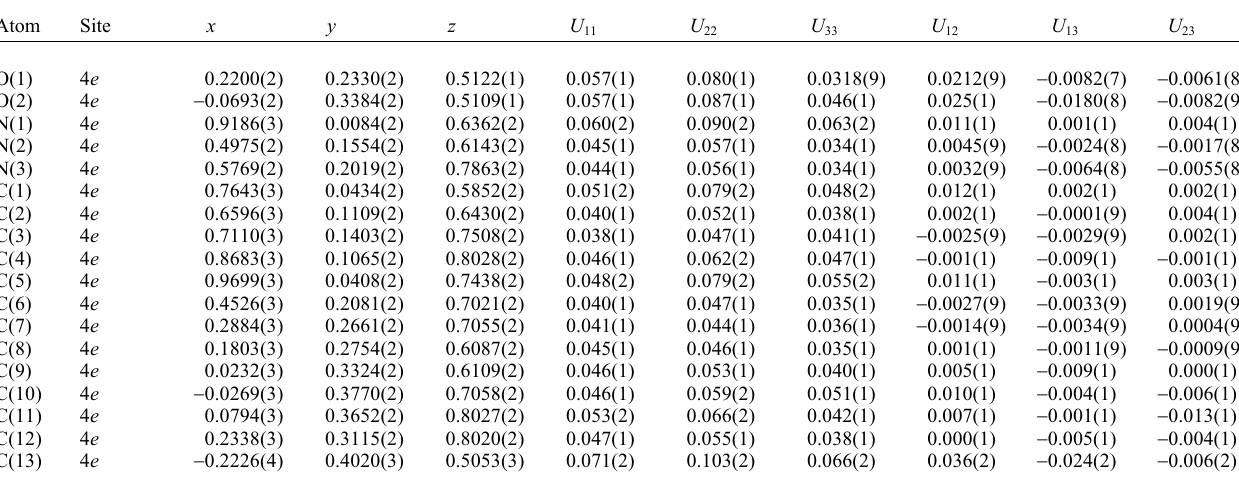
Table 3. Atomic coordinates and displacement parameters (in Å 2 )